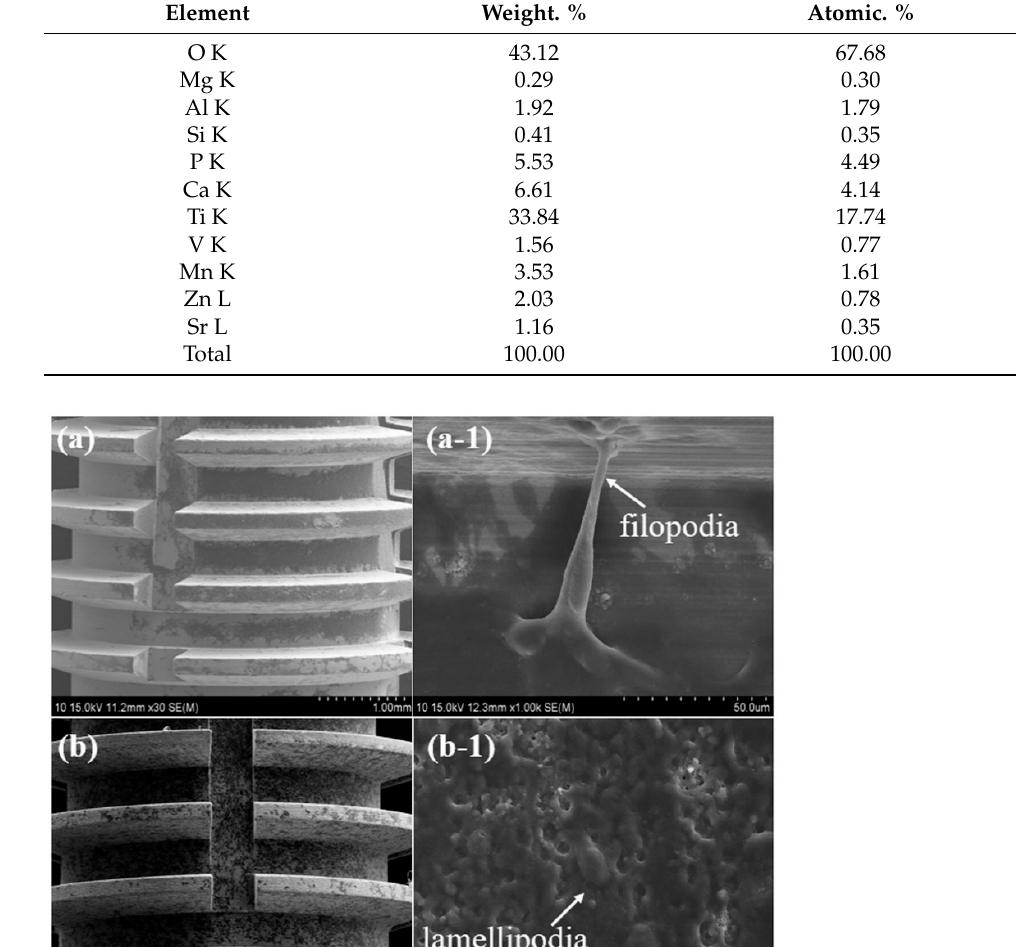
Table 1. EDS results of the Ti64/7 ion implant showing the incorporation of Ca, P, Mg, Zn, Si, Sr, and Mn into the coating.